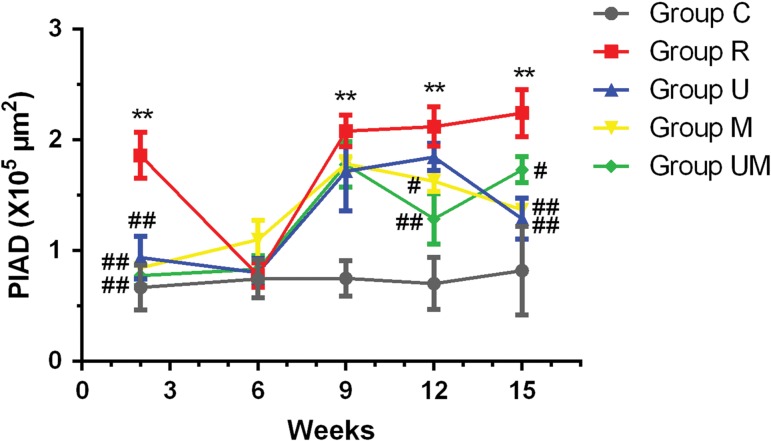
Dynamic changes in the PIAD in each group. The PIAD was significantly greater in Group R than in Group C at 2 weeks after radiation (P < 0.01), but significantly lower in Groups U, M and UM compared with that in Group R (all P < 0.01). No statistically significant differences were found between the groups at 6 weeks after radiation (P > 0.05). At 9 weeks after radiation exposure, the PIAD was greater in Groups R, U, M and UM than in Group C (all P < 0.01), but no statistically significant differences were found between these groups (P > 0.05). A significant difference emerged between Group M or UM and Group R at 12 weeks (P < 0.05 and P < 0.01, respectively), which predated the statistically significant difference observed between Group U and Group R at 15 weeks (P < 0.01). In addition, the statistically significant differences in the PIAD were still observed between Group M or UM and Group R (P < 0.01 and P < 0.05, respectively). **P < 0.01 vs Group C; #P < 0.05, ##P < 0.01 vs Group R.